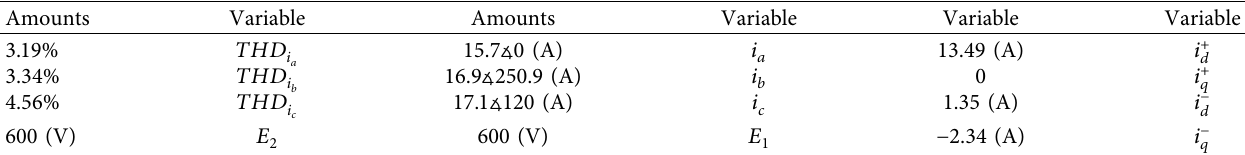
Figure 15: Harmonic distortion of three-phase input current under unbalanced condition; (a–c): current for phase a, b, and c with the proposed controller; (d–f): current for a, b, and c with the conventional controller. Table 3: Main components and DC value in the positive and negative sequence of currents and voltages and their THD value for the proposed